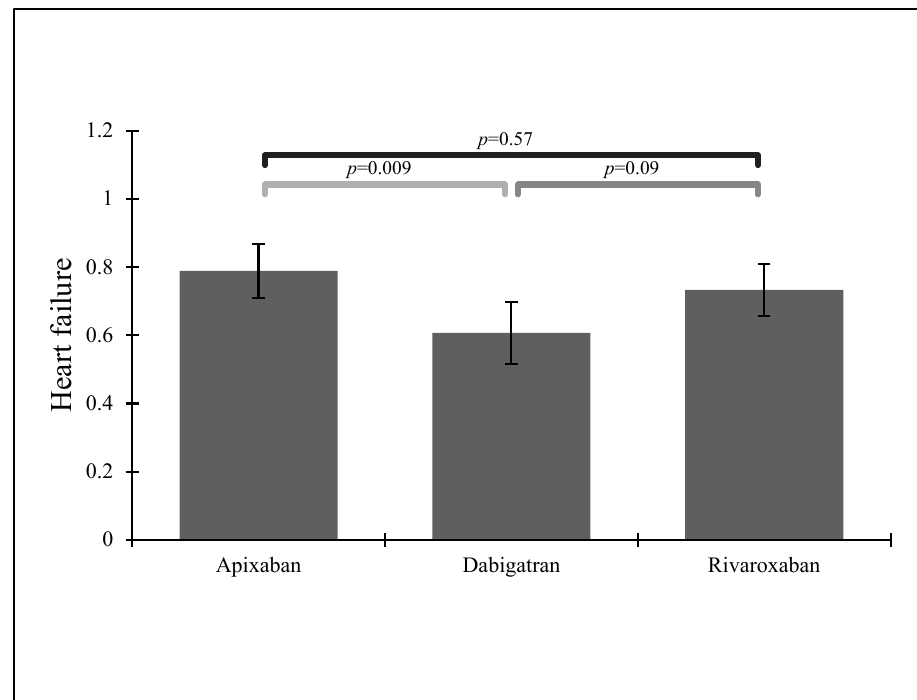
Figure 2. NOAC administration in patients with a previous stroke history and heart failure.